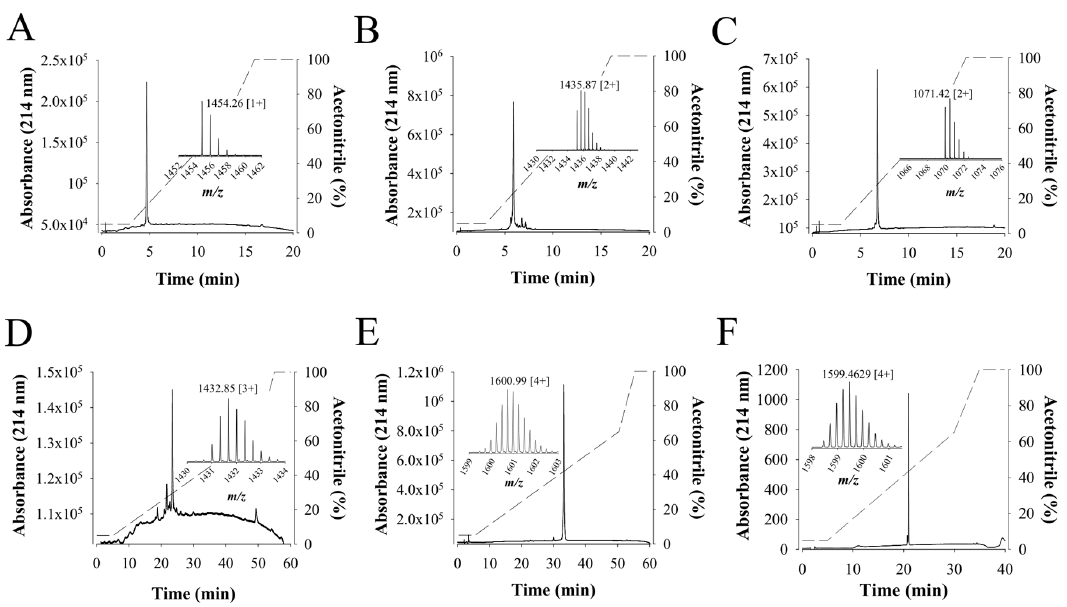
Figure 8. Chemical synthesis of walterospermin. ( A ) RP-HPLC purification of peptide fragment